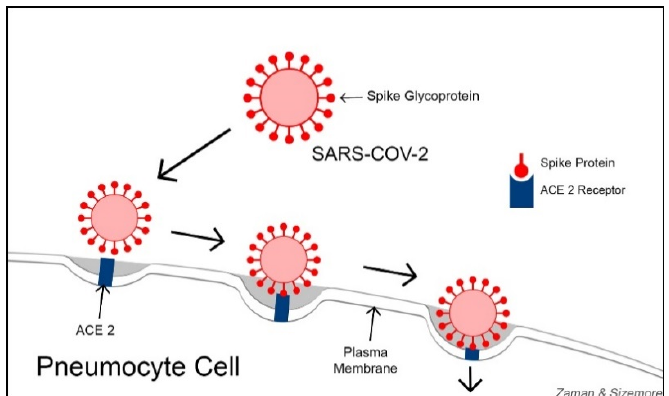
Figure 1. Spike glycoproteins of SARS-CoV-2 binding to ACE2 receptors on the plasma membrane before entering and infecting pneumocytes.